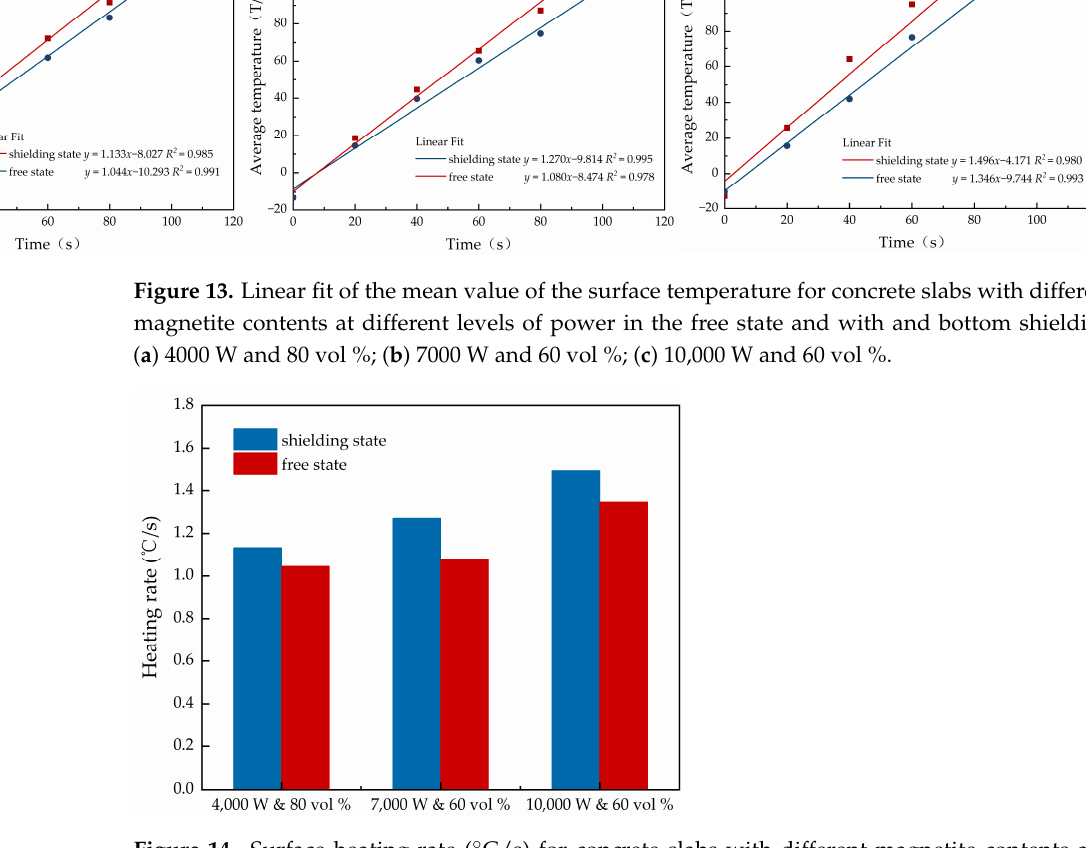
Figure 14. Surface heating rate (°C/s) for concrete slabs with different magnetite contents and dif- ferent levels of power in the free state and with and bottom shielding.